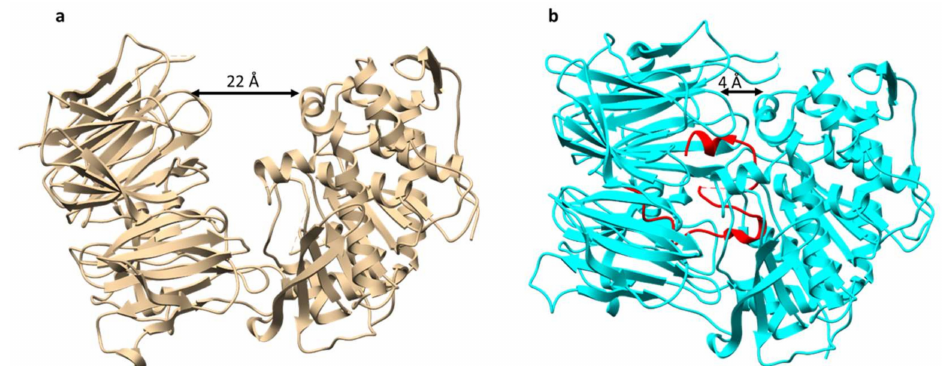
Figure 4. Overall structures of prolyl oligopeptidase POPB. ( a ) Structure of POPB from Galerina marginata species unbound to substrate (apoGmPOPB) in tan (PDB 5N4F), ( b ) S577A mutant of GmPOPB bound to 35-mer peptide (PDB 5N4C), S577A mutant in cyan, 35-mer peptide in red.